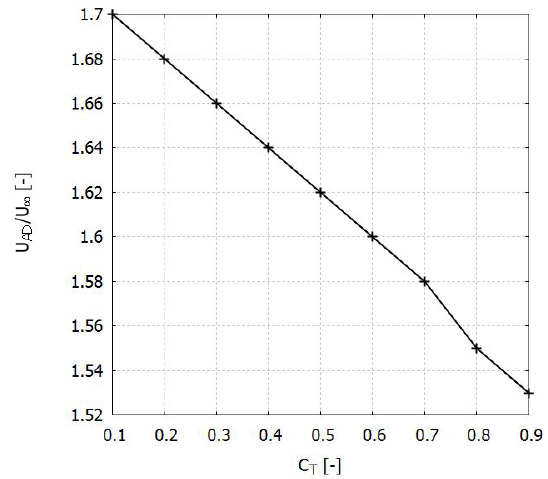
Figure 9. The result depicts the effect of varying the C T on the normalized velocity at the actuator